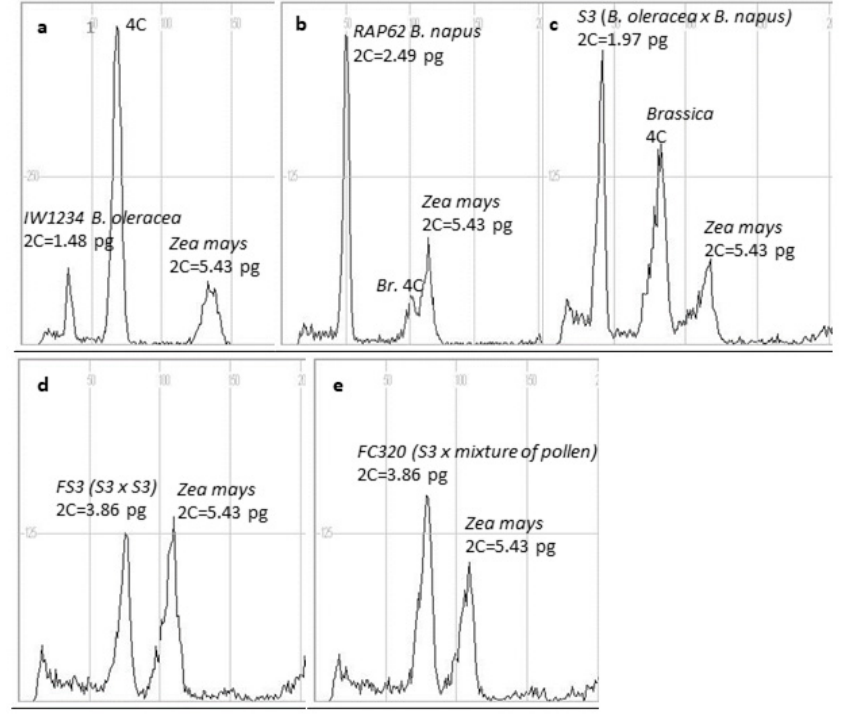
Figure 2. Histograms of nuclear DNA estimation using flow cytometry (FCM) for Brassica oleracea and hybrids with internal standard Zea mays (2C DNA = 5.43 pg). ( a ) IW1234 B . oleracea L. var. capitata (head cabbage); ( b ) RAP62 B . napus (rapeseed); ( c ) S3 F 1 (head cabbage × rapeseed); ( d ) FS3 F 2 (S3 × S3); ( e ) FC320 F 2 (S3 × mixture of pollen). Table 1. Nuclear DNA content and chromosome number of parental Brassica napus and B . oleracea lines and their interspecific hybrids in the F 1 and F 2 generation.